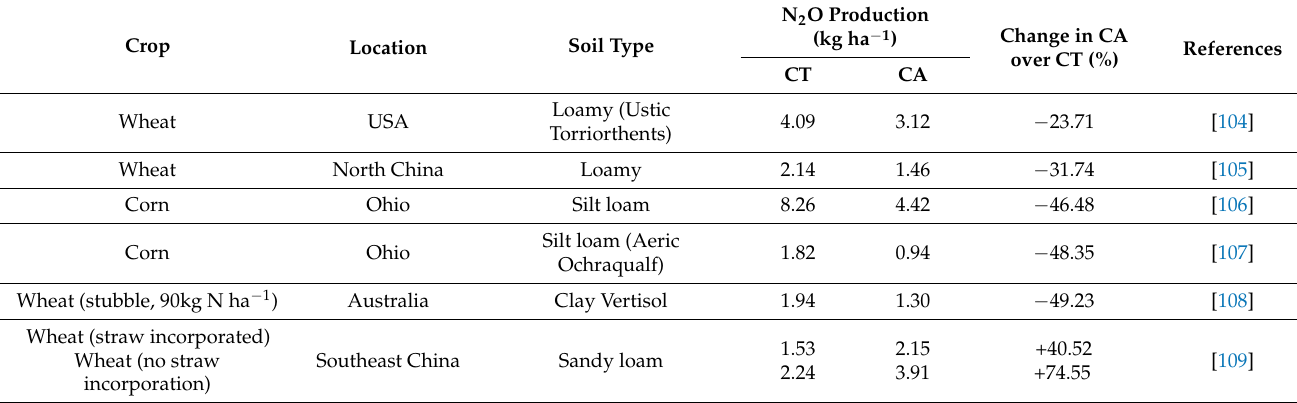
Table 4. N 2 O production in some of the conventional (CT) and conservation agriculture (CA: reduced or no-till) practices.